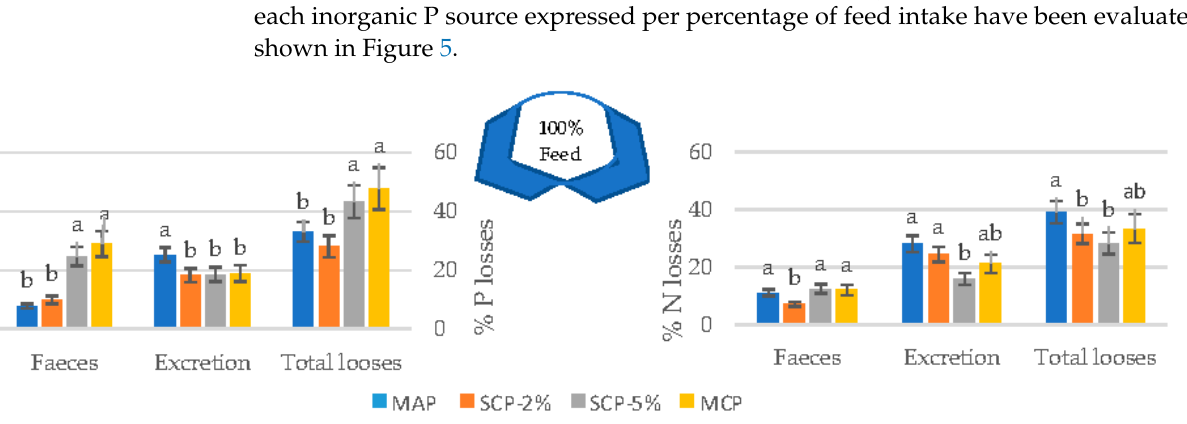
Figure 4. Daily pattern of soluble total P excretion rate (expressed in mg of P per kg of fish biomass and hour) of rainbow trout fed four inorganic P sources. Each point represents the average ( ± SE) of four tanks. Different superscripts indicate statistically significant differences with p < 0.05. A Newman–Keuls test was used to compare the means. The amount of P excretion was determined based on the P concentration in water and the water flow every hour after feeding over a 24-h period.